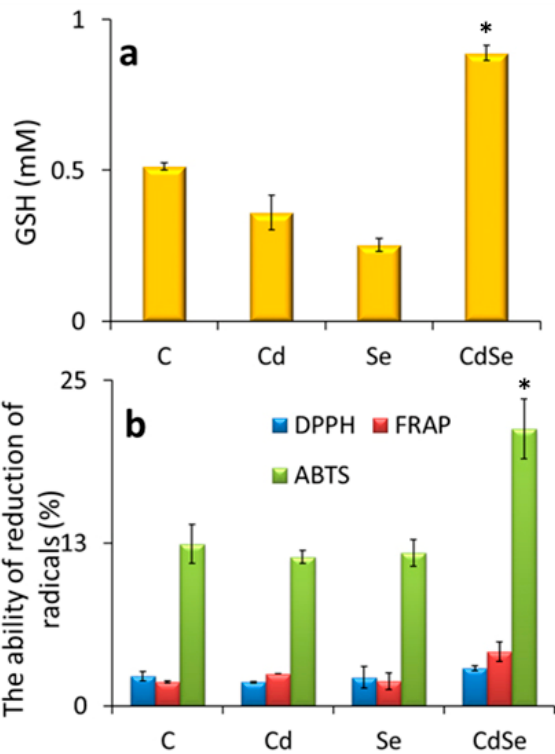
Figure 3. GSH production and antioxidant properties. ( a ) GSH production; ( b ) the antioxidant activity of the yeast cells (with or without the precursors) was determined during the QD biosynthesis. Data represent the mean ±SD, n = 5. Data represent the mean ±SD of the mean of three individual experiments. * p < 0.01 or ** p <